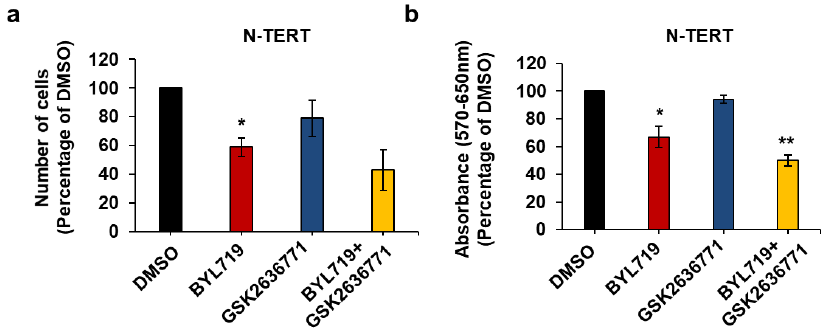
Figure 5. p110 β does not play a major role in N-TERT growth and viability upon p110 α inhibition. N-TERT cells were treated with 1 µM of the indicated inhibitors alone or in combination in complete medium supplemented with 10% FBS. Control cells were treated with DMSO. After 72 h, number of cells was assessed by cell counting ( a ) and cell viability was assessed by MTT assays ( b ). Data are expressed as percentage of results from control cells and are means ± SEM from n = 3 ( a ) and n = 4 ( b ) independent experiments performed in duplicate ( a ) or triplicate ( b ). * p < 0.05, ** p < 0.01 vs. DMSO. Taken together, these data demonstrated that BYL719 inhibits growth and viability of keratinocytes more potently than the other inhibitors tested, suggesting that p110 α is the main PI3K isoform regulating such cellular functions in these cells.